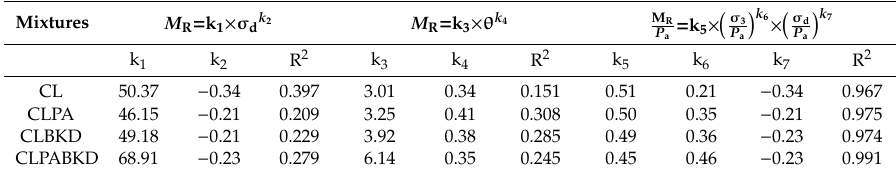
Table 10. Model constants for the optimum mixtures (Soaked).